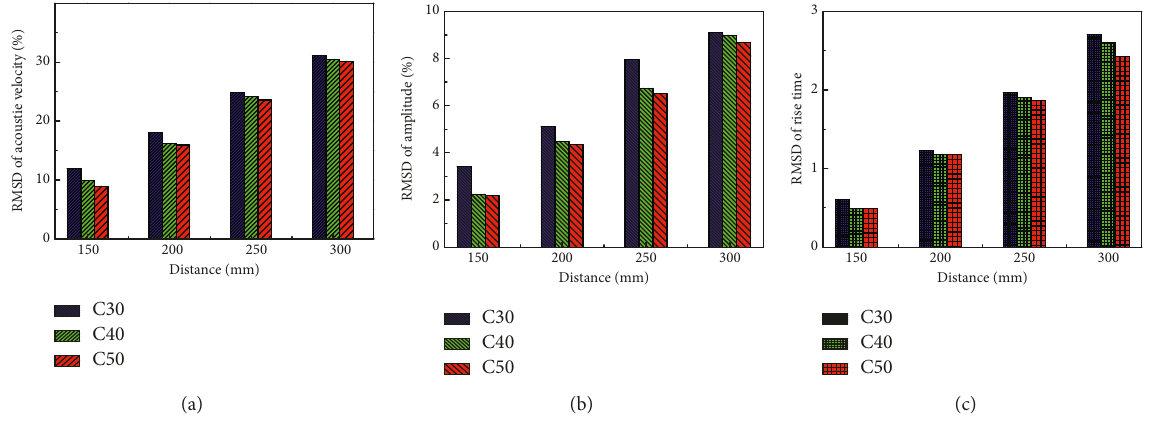
Figure 13: RMSD indexes of (a) acoustic velocity, (b) amplitude, and (c) rise time. Table 2: The variation of characteristic parameters and RMSD index in two cases. The relation between the The concrete wavefront and the sensor strength